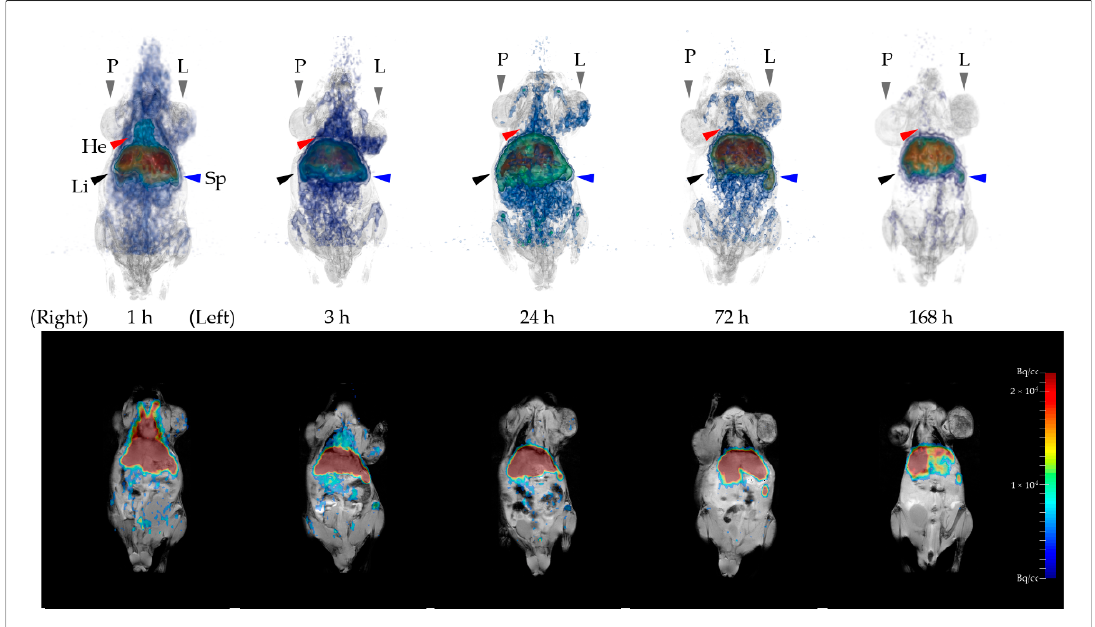
Figure 4. Fused PET and MR imaging data for a single SCID-mouse injected with [ 89 Zr]Zr-DFO-NDs (I) measured 1 h, 3 h, 24 h, 3 d and 7 d post injection. In the anterior view a maximum intensity projection (MIP) is combined with a volumetric representation of the MR data (upper row). Additionally, a coronal MR section is combined also in the anterior view, with the respective 2D PET images. The PET data were well matched to the specific tissues by the anatomical image information from MRI. The labeled organs are He = Heart, Li = Liver, Sp = Spleen, P = PC-3 tumor, L = LNCaP C4-2 tumor.